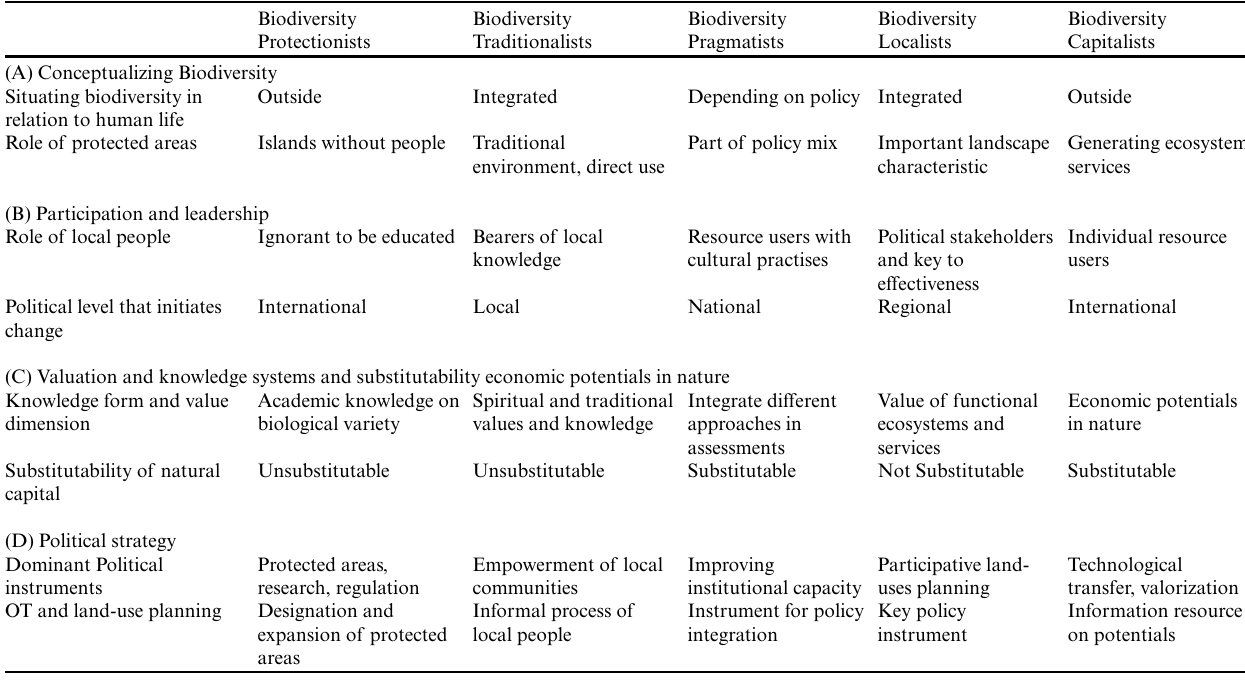
Table 3 . The five identified conservation narratives and their perspectives on four key